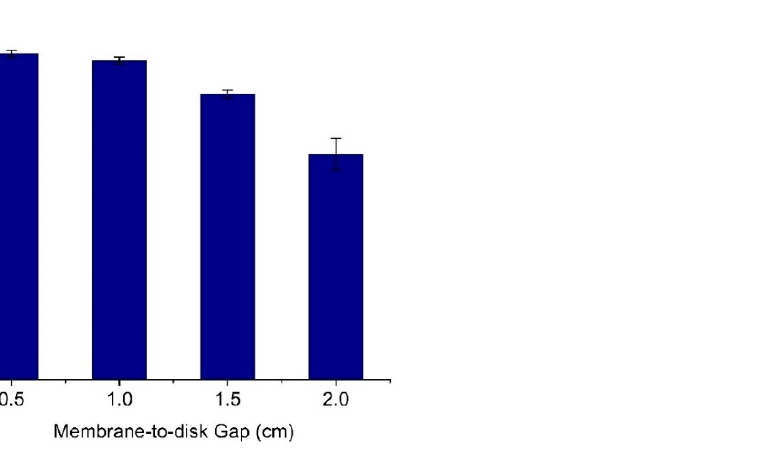
Figure 7. The effect of the membrane-to-disk gap on the permeability. A narrow gap offered a higher hydraulic throughput.